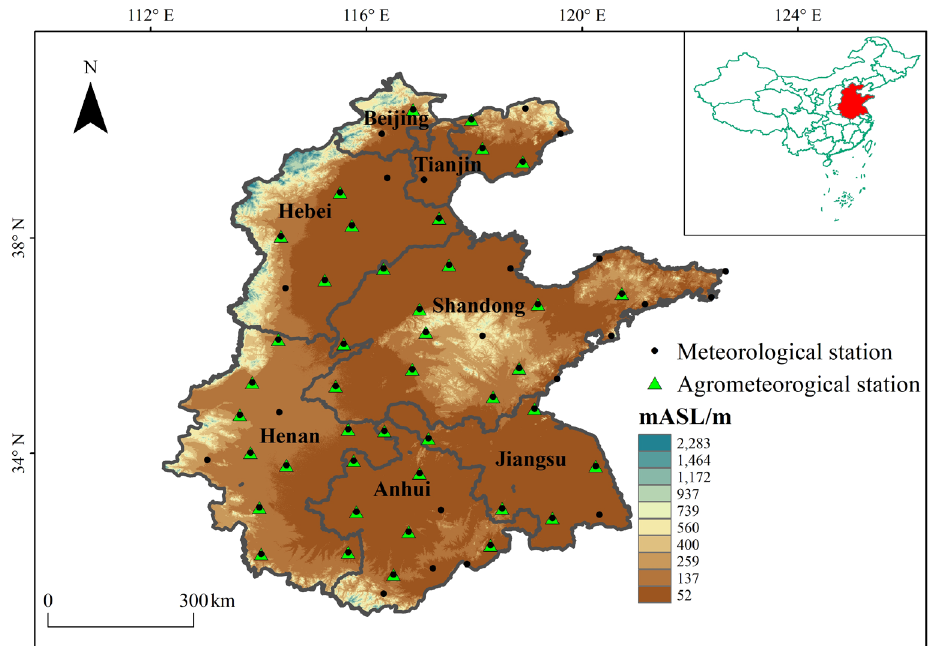
Figure 1. Location and station distribution of the North China Plain (elevation data comes from SRTM 90 m DEM Digital Elevation Database). SRTM 90 m DEM Digital Elevation